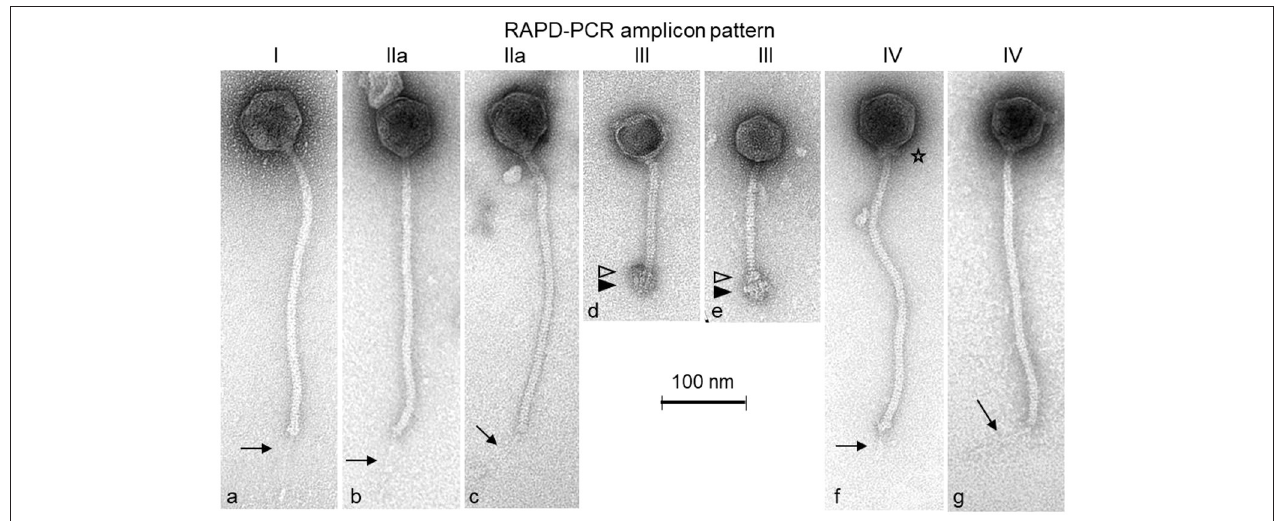
FIGURE 1 | Transmission electron micrographs of the S. hyicus phages PITT-1 (a) , PITT-2 (b) , PITT-3 (c) , PITT-4 (d) , PITT-5 (e) , PITT-6 (f) , and PITT-7 (g) negatively stained with 2% (w/v) uranyl acetate. Structural details are indicated by arrows (faint distal central tail fibers), by open triangles (upper disc of complex baseplate structure), by filled triangles (lower disc of complex baseplate structure), and by an asterisk (collar/neck passage structure). All micrographs are shown with the same magnification (see 100-nm size reference bar). The RAPD-PCR patterns I, IIa, III-IV (see also Figure 2 ) are indicated on top of the micrographs.